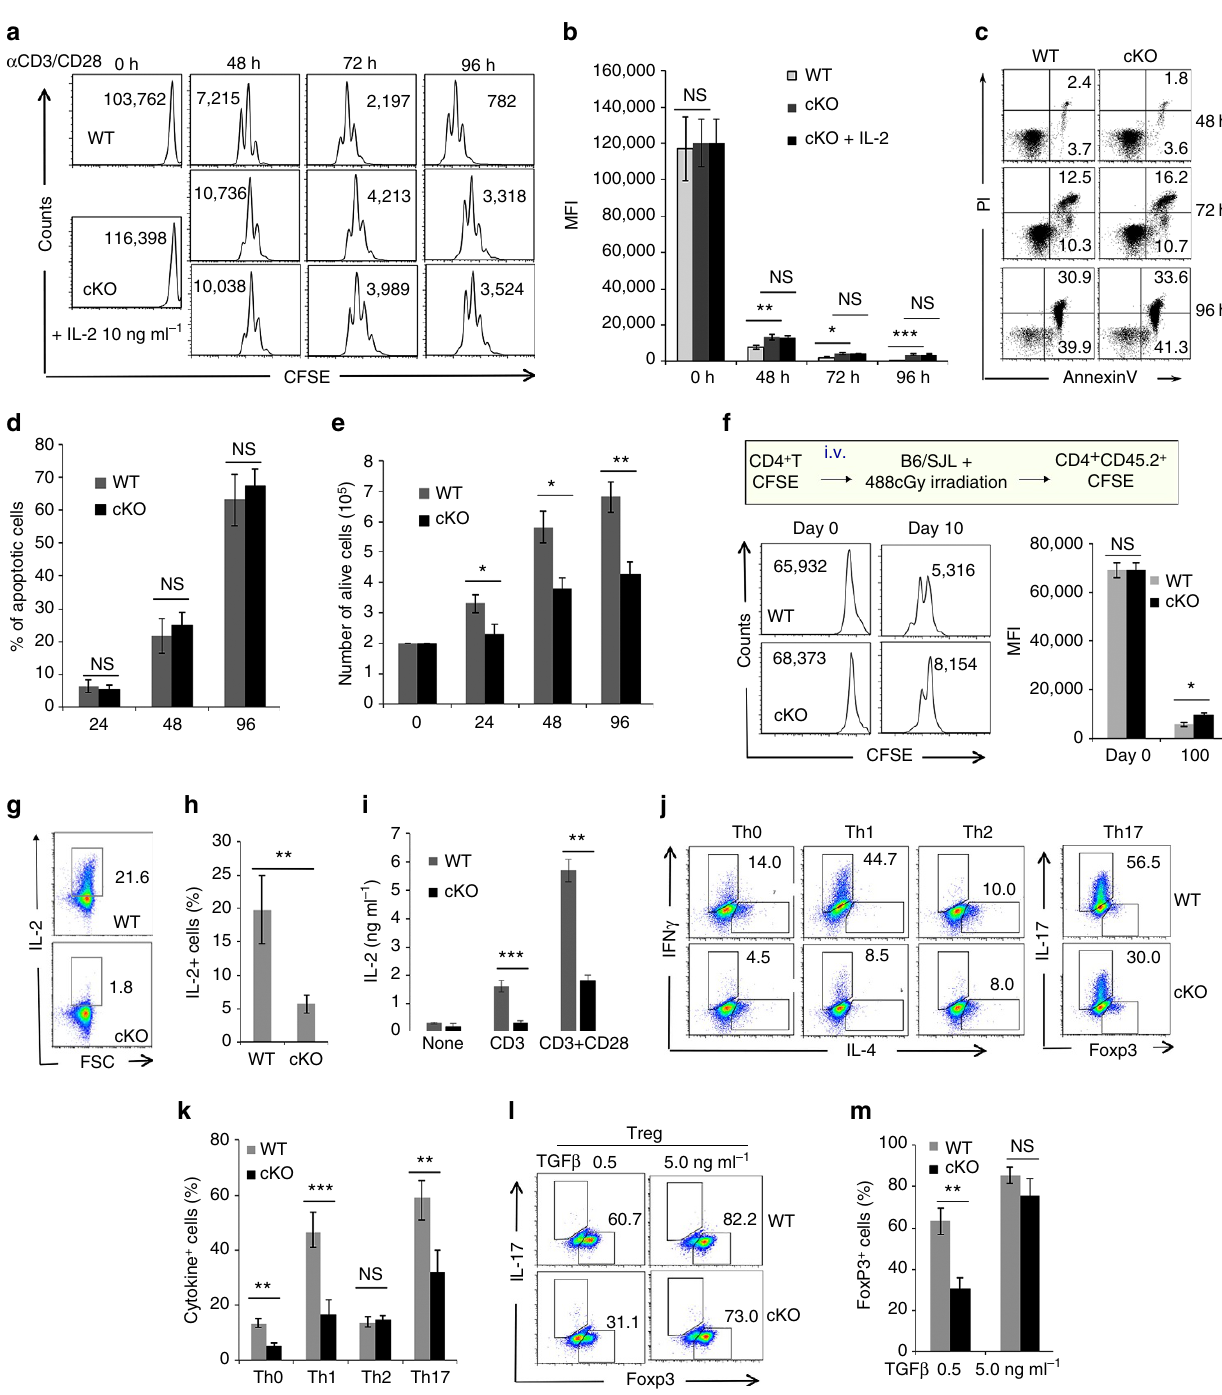
Figure 1 | In vitro activation and differentiation of Hrd1 cKO Tcells. ( a – e ) Naive CD4 Tcells were purified from the spleens of WTand Hrd1 cKO mice, and stained with CFSE. Cells were then cultivated in the presence of anti-CD3 plus anti-CD28 antibodies (1mgml (cid:2) 1 each). Cell proliferation ( a , b ) and apoptosis ( c , d ) at each indicated time point were analysed by flow cytometry. The representative data ( a , c ) and the averages ( b , d ) from five independent experiments are shown. ( e ) The absolute numbers of dividing cells from five independent experiments are indicated. ( f ) CFSE-stained cells were adoptively transferred into B6/SJL congenic mice bearing a CD45.1 marker. Ten days after the transfer, receipt mice were killed and the CD45.2 þ CD4 Tcells were gated for their CFSE dilution. Representative images (left panels) and the averages (right panels) from three pairs of mice were shown. ( g – m ) Naive CD4 Tcells from WTand Hrd1 cKO mice were cultivated with anti-CD3 plus anti-CD28 ( g – i ) or at each polarization condition ( j – m ). IL-2 production and Th-cell differentiation were analysed by intracellular staining as described in the materials and methods ( g , h ). IL-2 in the culture supernatants 3 days after anti-CD3 plus anti-CD28 stimulation was analysed by enzyme-linked immunosorbent assay (ELISA). ( i ) The representative images ( g , j , l ) and the mean ± s.d. ( h , i , k , m ) from five independent experiments are shown. The Mann–Whitney test was used for the statistical analysis. NS, no significant difference; * P o 0.05, ** P o 0.01 and *** P o 0.001.